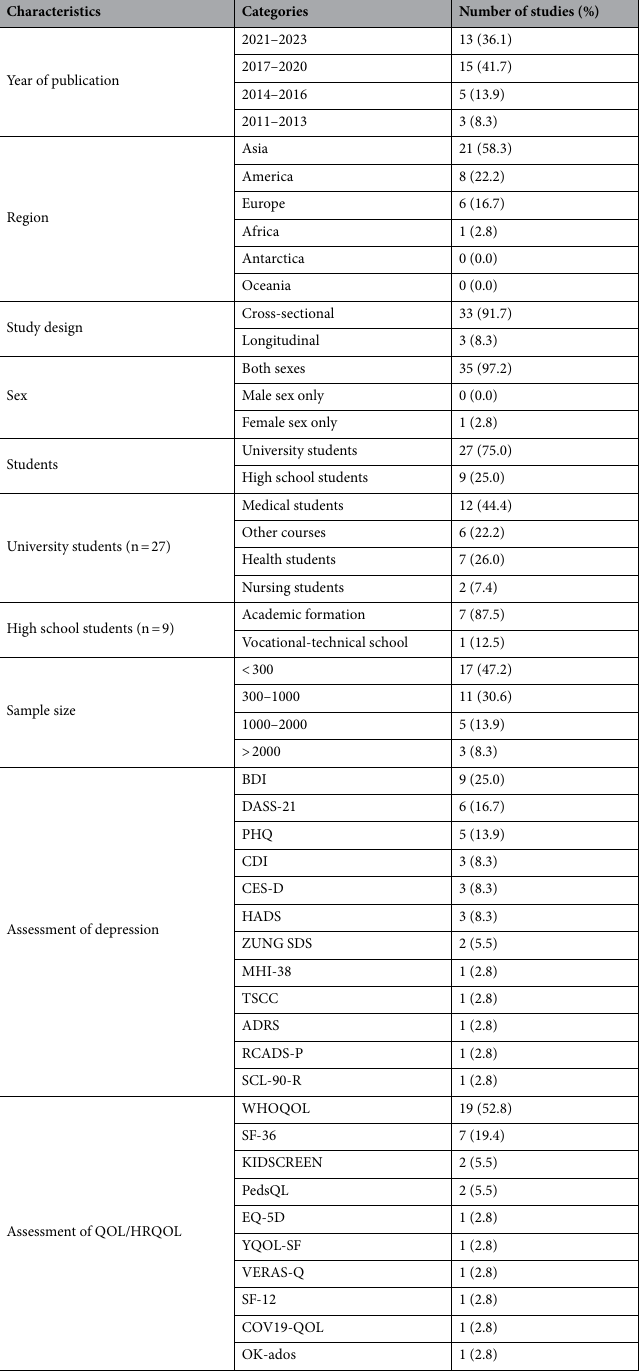
Table 3. Quantitative characteristics of the articles included in the systematic review (n = 36). ADRS: Adolescent Depression Rating Scale; CES-D: Center for Epidemiological Studies Depression Scale; DASS: Depression, Anxiety, and Stress Scale; DS: Domain scores; EQ-5DVAS: Visual Analogue Scale; ES: Effect size; HADS: Hospital Anxiety and Depression scale; HRQOL: health-related quality of life; CI: confidence interval; MHI-38—Mental health inventory; NR: not reported; OK-ados: OK-ados questionnaire; OR: odds ratio; PedsQL: Pediatric Quality of life Inventory; PHQ: Patient Health Questionnaire; QOL: quality of life; RAND 36-Item Health Survey; RCADS-P: Revised children anxiety and depression scales, parent form; SF-8: Optum Short Form-8 Health Survey; SF-36: Short Form Health Survey; TSCC: Trauma Symptom Checklist for Children; WHOQOL: The World Health Organization Quality of Life Questionnaire; WHOQOL-BREF: The World Health Organization Quality of Life Questionnaire—short version; WHOQOL-BREF-THAI: The World Health Organization Quality of Life Questionnaire—Thai version; YQOL-SF: Life Instrument-Short Form; ZUNG SDS: Zung self-rating depression